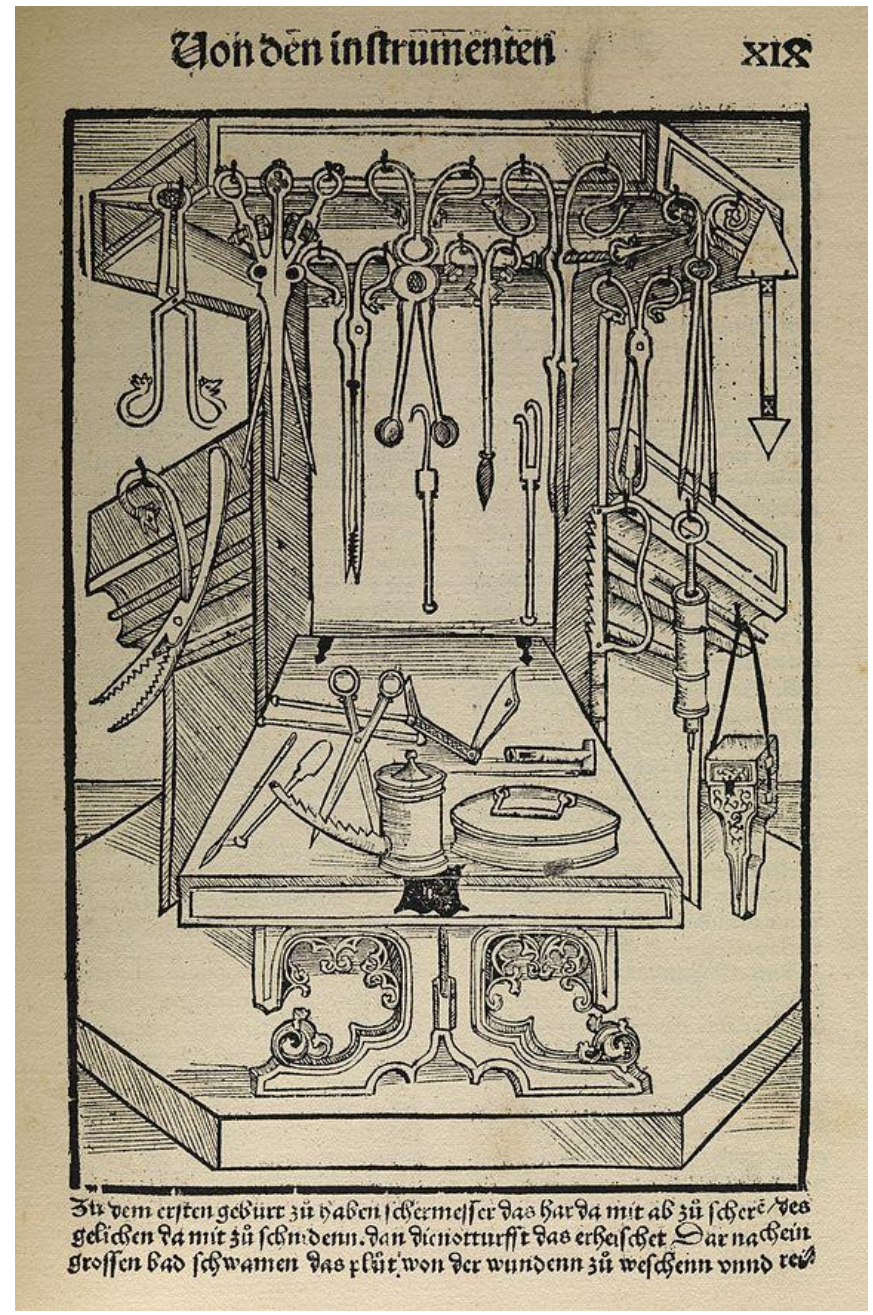
Figure 3. Surgical tools including an instrument case (far right). Hieronymus Brunschwig, Buch der Cirurgia (Strasbourg: Johann Grüninger, 1497), fo. 17r. Munich, Bayerische Staatsbibliothek—2 Inc.c.a.